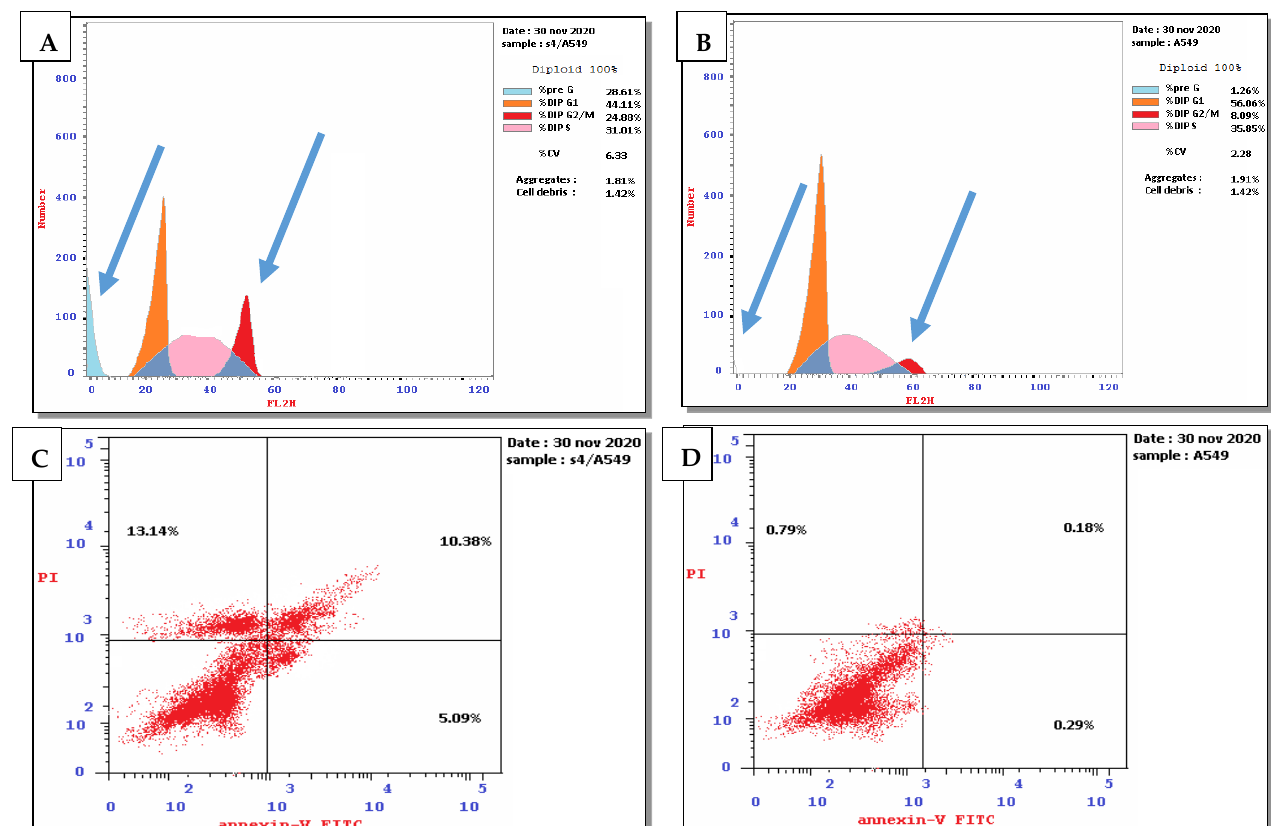
Figure 3. ( A ) Effect of compound 1 on the cell cycle distribution of non-small-cell lung cancer A549 cell line. ( B ) Untreated lung cancer cell as a negative control. ( C ) Apoptosis induced by compound 1 using non-small-cell lung cancer A549 cell line. ( D ) Apoptosis in untreated cells as negative control. The four quadrants identified as: lower left: viable; lower right: early apoptotic; upper right: late apoptotic; upper left: necrotic.